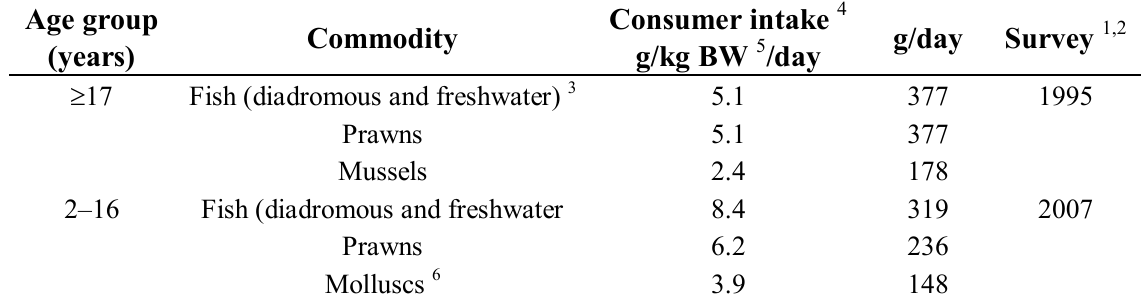
Table 1. High level seafood consumption (97.5th